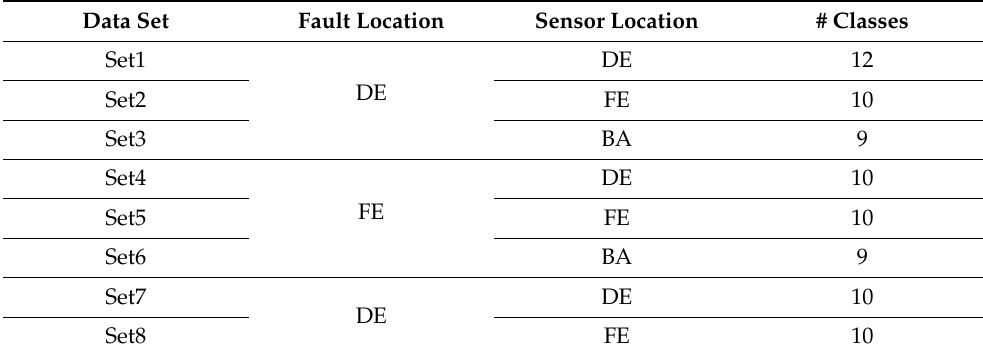
Table 8. CWRU Dataset Configuration.